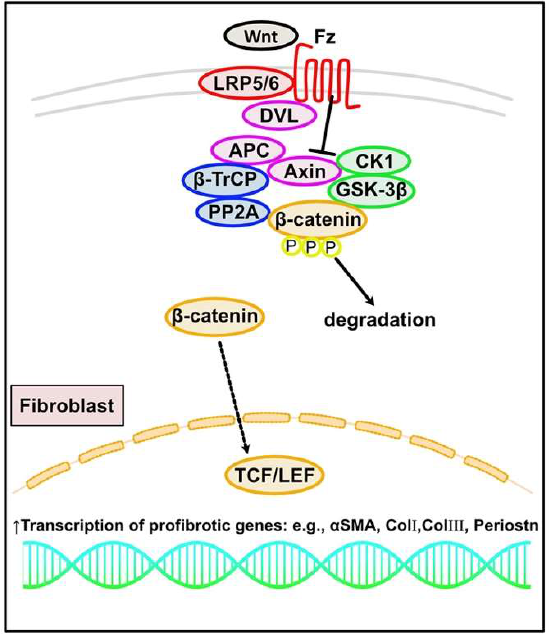
Figure 5. Canonical WNT/β-catenin signaling in cardiac fibrosis. In the absence of Wnt ligands, cy- tosolic β-catenin is degraded by the destruction complex, which includes Axin and adenomatous polyposis coli (APC), glycogen synthase kinase (GSK)-3β and casein kinase (CK)1, protein phospha- tase 2A (PP2A), and β-transducin repeat-containing protein (β-TrCP). After a Wnt ligand binds to the receptor Frizzled (Fz) and the receptor-related protein 5 or 6 (LRP5/6) coreceptor, the Wnt–Fz– LRP5/6 complex recruits Disheveled (DVL) and Axin through the intracellular domains of Fz and LRP5/6, resulting in β-catenin stabilization. The increased nuclear levels of β-catenin promote inter- action with T cell factor/lymphoid enhancer factor (TCF/LEF) transcription factor to regulate Wnt- responsive fibrotic